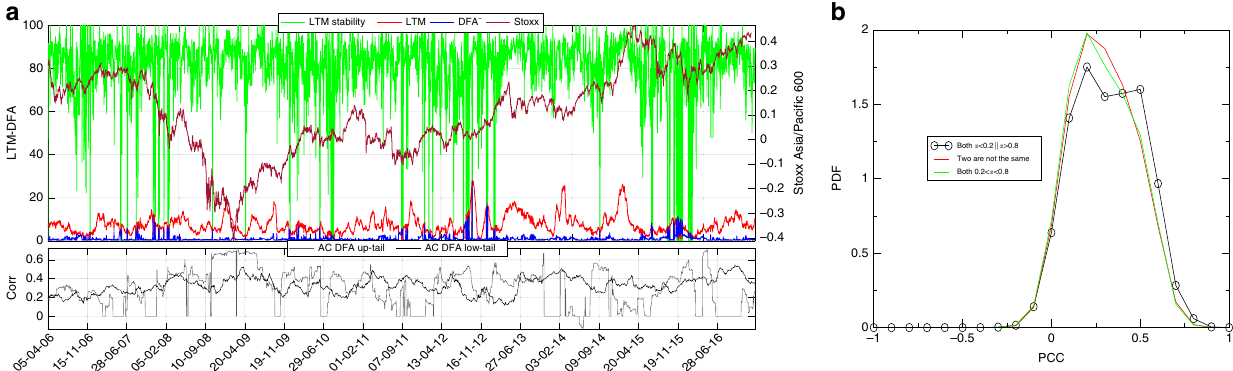
Fig. 2 LTM membership stability. a Shows in green the percentage of stocks that belong to the LTM for two consecutive trading days (LTM stability), while the red line stands for the percentage of stocks belonging to the LTM. The blue line emphasizes the percentage of DFA − stocks. The black line shows the value of the correlation (Corr) between the number of stocks selected by the DFA and the average correlation of these stocks' returns, for those having a DFA exponent signi fi cantly larger than 1/2 (AC DFA up-tail), while the gray line refers to stocks with a DFA exponent signi fi cantly lower than 1/2 (AC DFA low-tail). Finally, the dynamics of the series are compared with the market index (reported in orange). b Shows the distributions of pairs of stocks such that both stocks have Hurst exponent outside the interval 0.2 – 0.8 (in black), of pairs such that none of them is outside the interval 0.2 – 0.8 (in green) and those with only one stock belonging to such interval (in